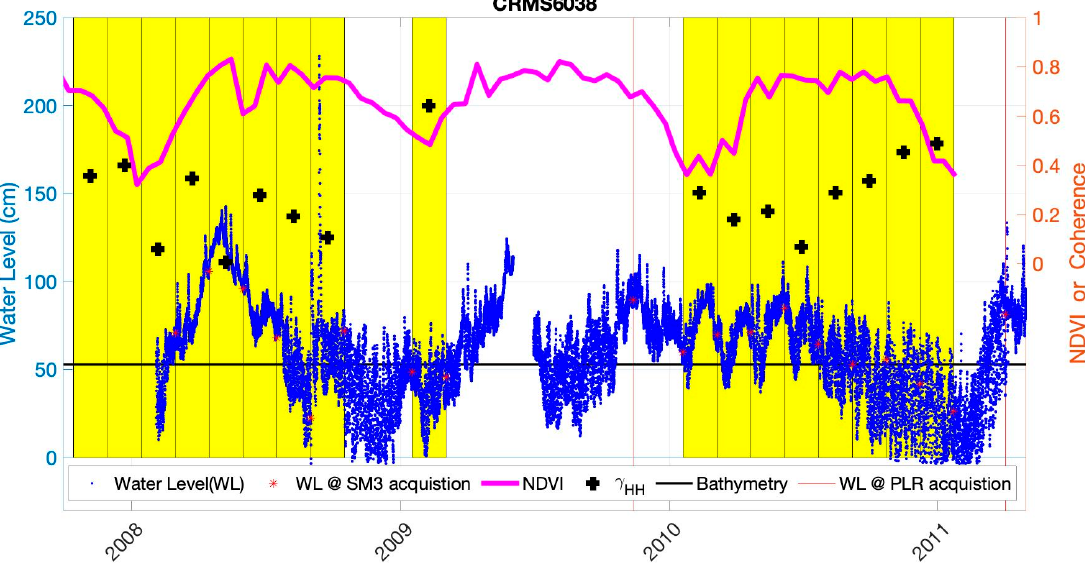
Figure 11. Time-series water level and NDVI at CRMS6038 during the study period. Water levels extracted during SAR acquisition are marked. Each yellow bar corresponds to the period of one InSAR pair. The coherence is marked in the middle of each pair. The wetland elevation from USGS DEM is plotted as a horizontal black line and is used as a reference for comparison with the CRMS water level in the channel, shown as blue dots. Water level data was not recorded in early 2008 and the middle of 2009.